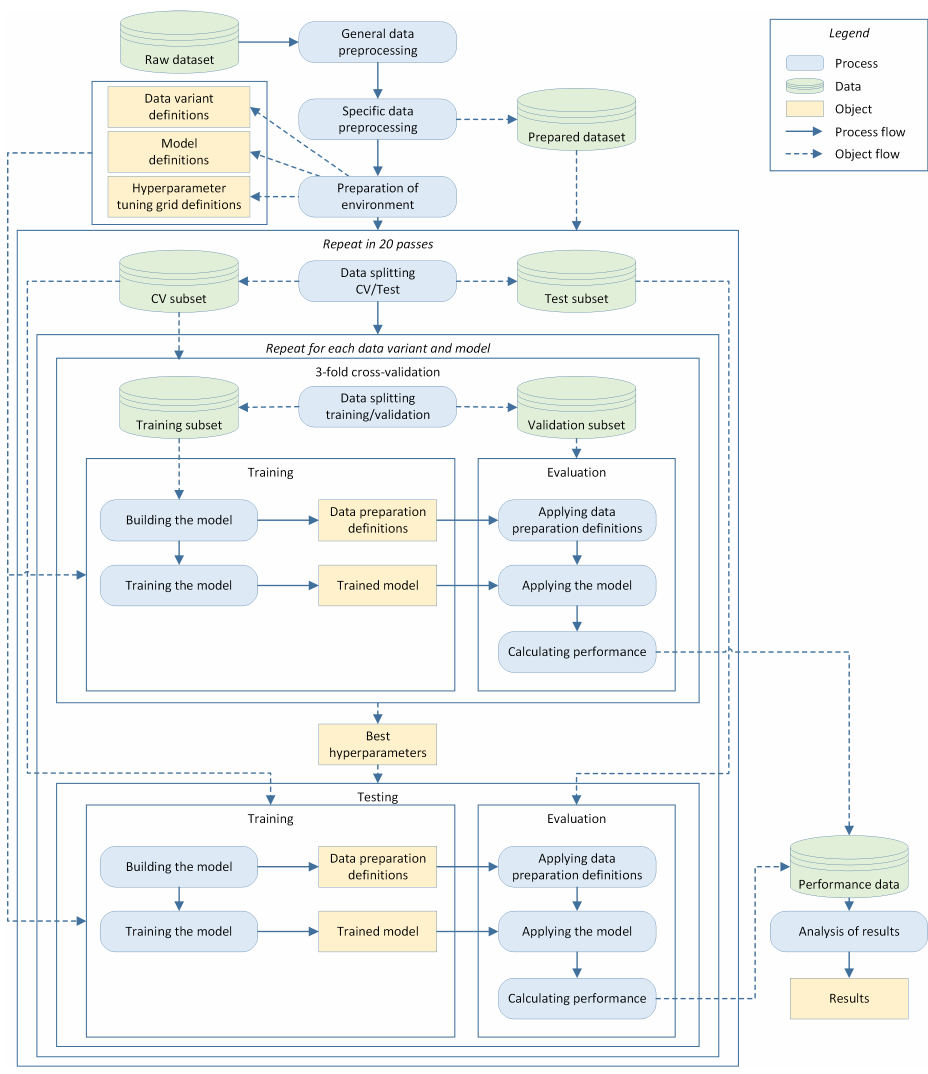
Figure 1. Overview of the research